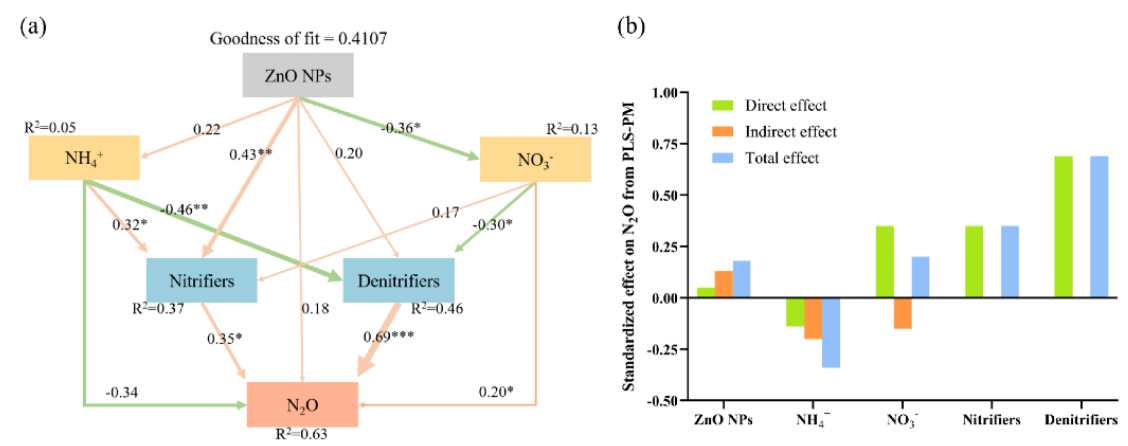
Figure 5. Direct and indirect effects of ZnO NPs on N 2 O emissions in PLS-PM. The left figure ( a ) describes the relationships among ZnO NPs, soil NH 4+ , NO 3 − , nitrifiers and denitrifiers with respect to N 2 O emissions. Wider arrows indicate higher path coefficients, and orange and green colors indicate positive and negative effects, respectively. *, ** and *** indicate significance at p < 0.05, p < 0.01, and p < 0.001, respectively. The right figure ( b ) describes the standardized direct, indirect and total effects derived from the PLS-PM.